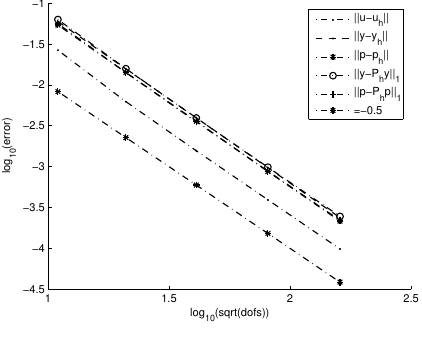
Figure 3. The order of convergence, Example 2.